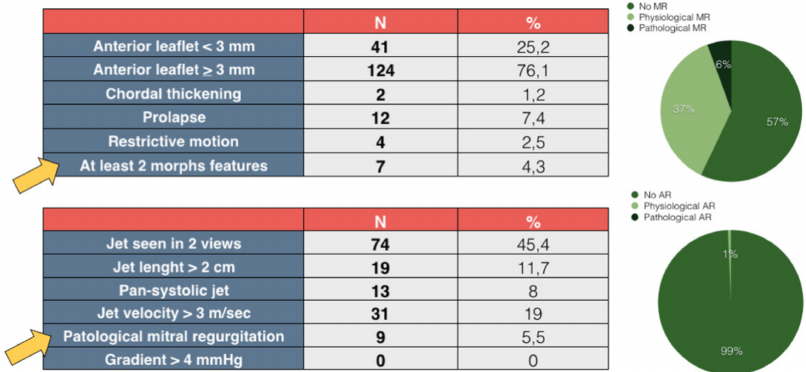
Figure 2. Results of the RHD screening. This figure summarizes the results of the RHD screening. Specifically, the top-left table shows the MV morphological features and the percentage of subjects showing at least 2 features (yellow arrow). The lower-left table shows the Doppler characteristics of MR jets and the percentage of patients who met the “ pathological ” MR definition (yellow arrow). In the upper-right diagram, the population is divided according to MR characteristics (none, physi- ological, pathological). The same division is made in the lower right for AR. Abbreviations: RHD: rheumatic heart disease; MR: mitral regurgitation; AR: aortic regurgitation; MV: mitral